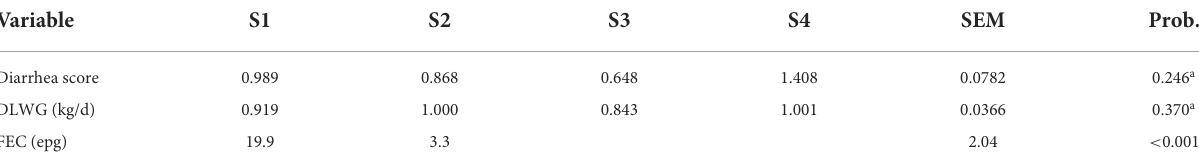
TABLE 4 Diarrhea score, daily live weight gain and pooled rumen fluke fecal egg counts. Variable S1 S2 S3 S4 SEM Prob.